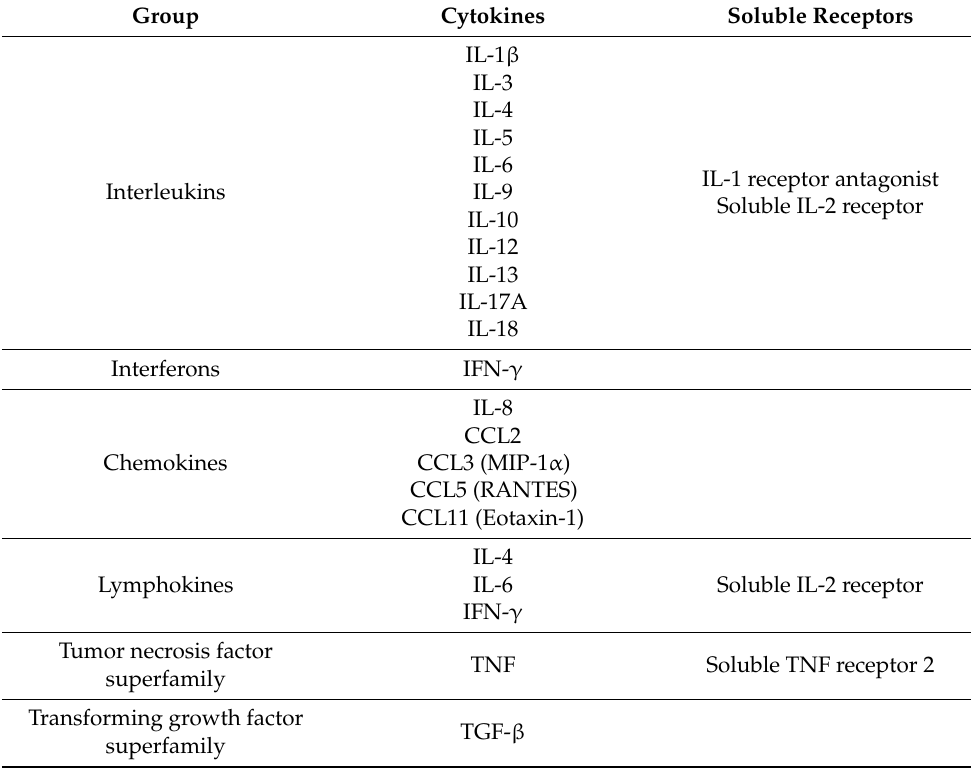
Table 1. Cytokine groups with participating receptors and ligands.